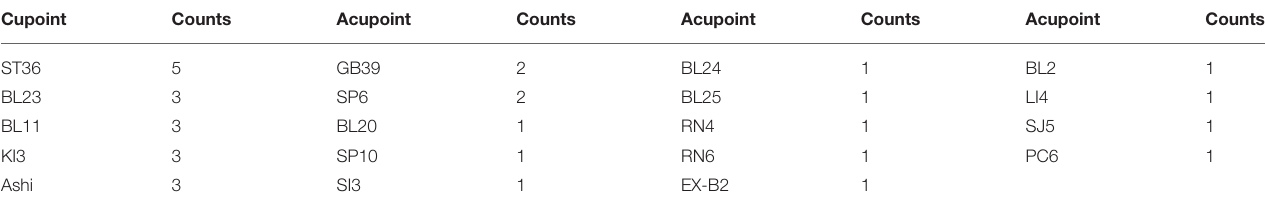
TABLE 7 | Details of meridian